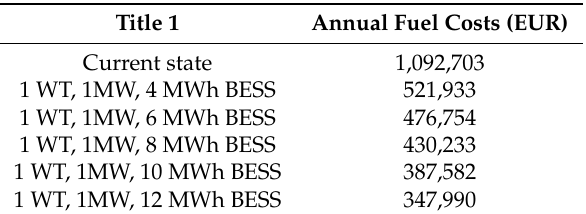
Table 3. Comparison of annual fuel costs for considered scenarios in Astypalaia Island.